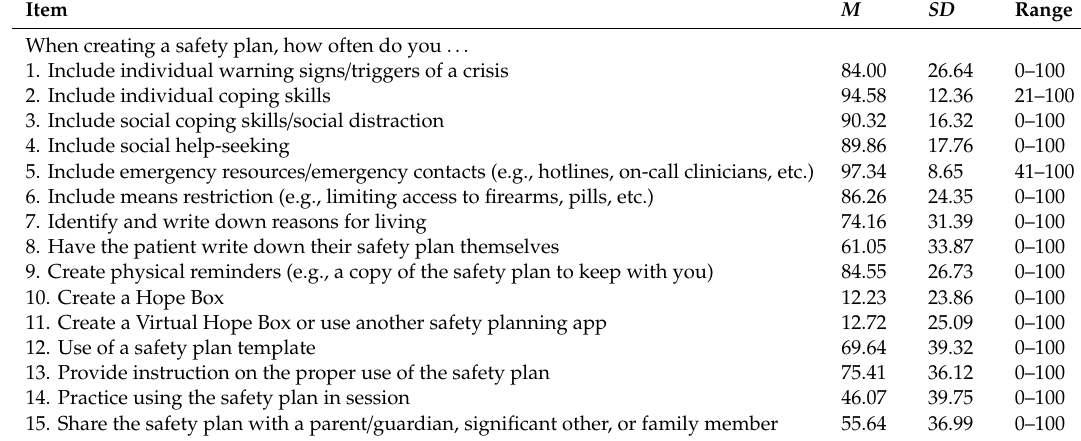
Table 1. Clinicians’ estimated percent of the time they include major components of the safety plan.